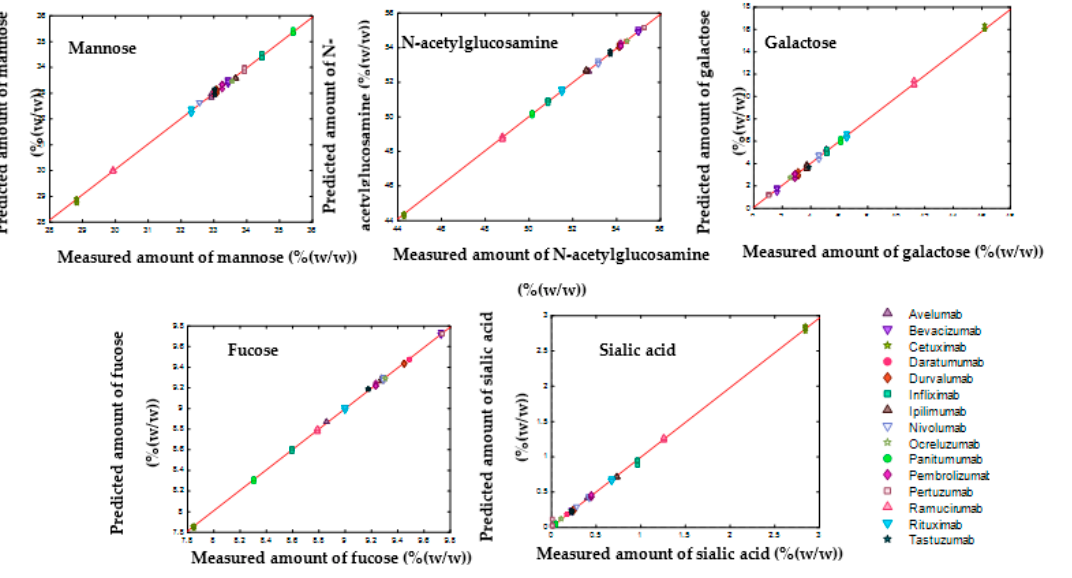
Figure 9. Measured versus predicted amounts of monosaccharides obtained by SVR regression be- tween 800 and 1150 cm − 1 for the analysis of the amount of each monosaccharide at low concentration (3 mg mL − 1 ) of mAbs. Table 3. Performances of SVR models in predicting monosaccharides at low